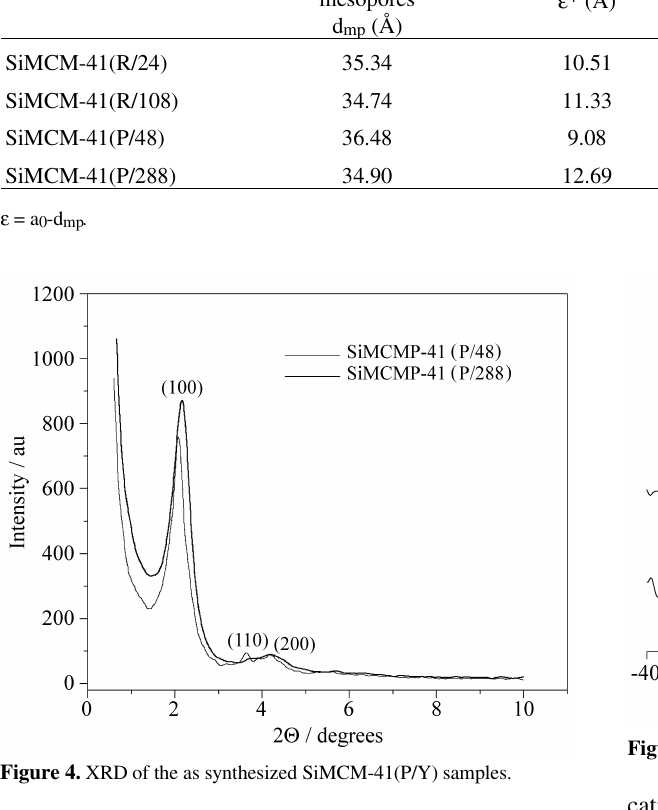
Table 3. Textural characteristics of the calcined SiMCM-41 samples. Sample